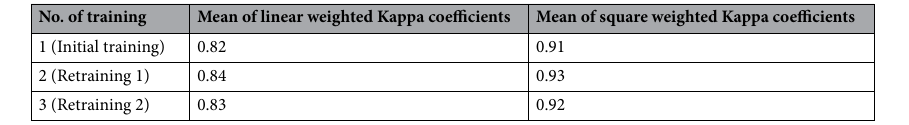
Table 7. Overview of linear and squared weighted Kappa coefficients as measures of interrater reliability (re-training 1 and 2 was performed during the course of the study).